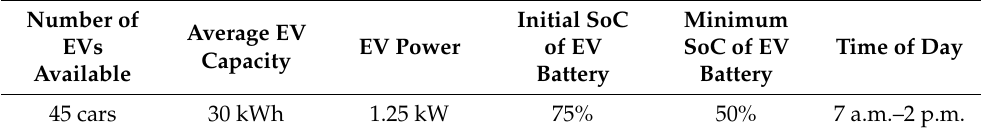
Table 2. EV integration